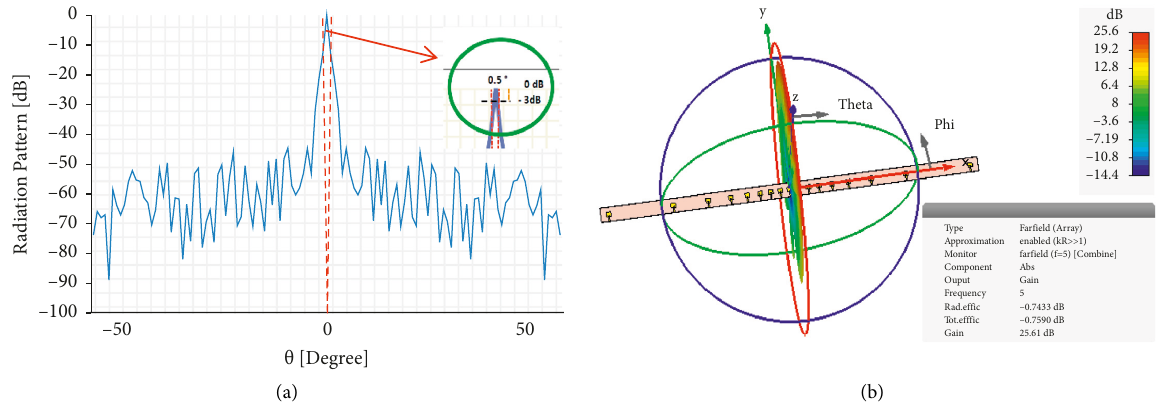
Figure 5: 17-Element sparse array configuration radiation